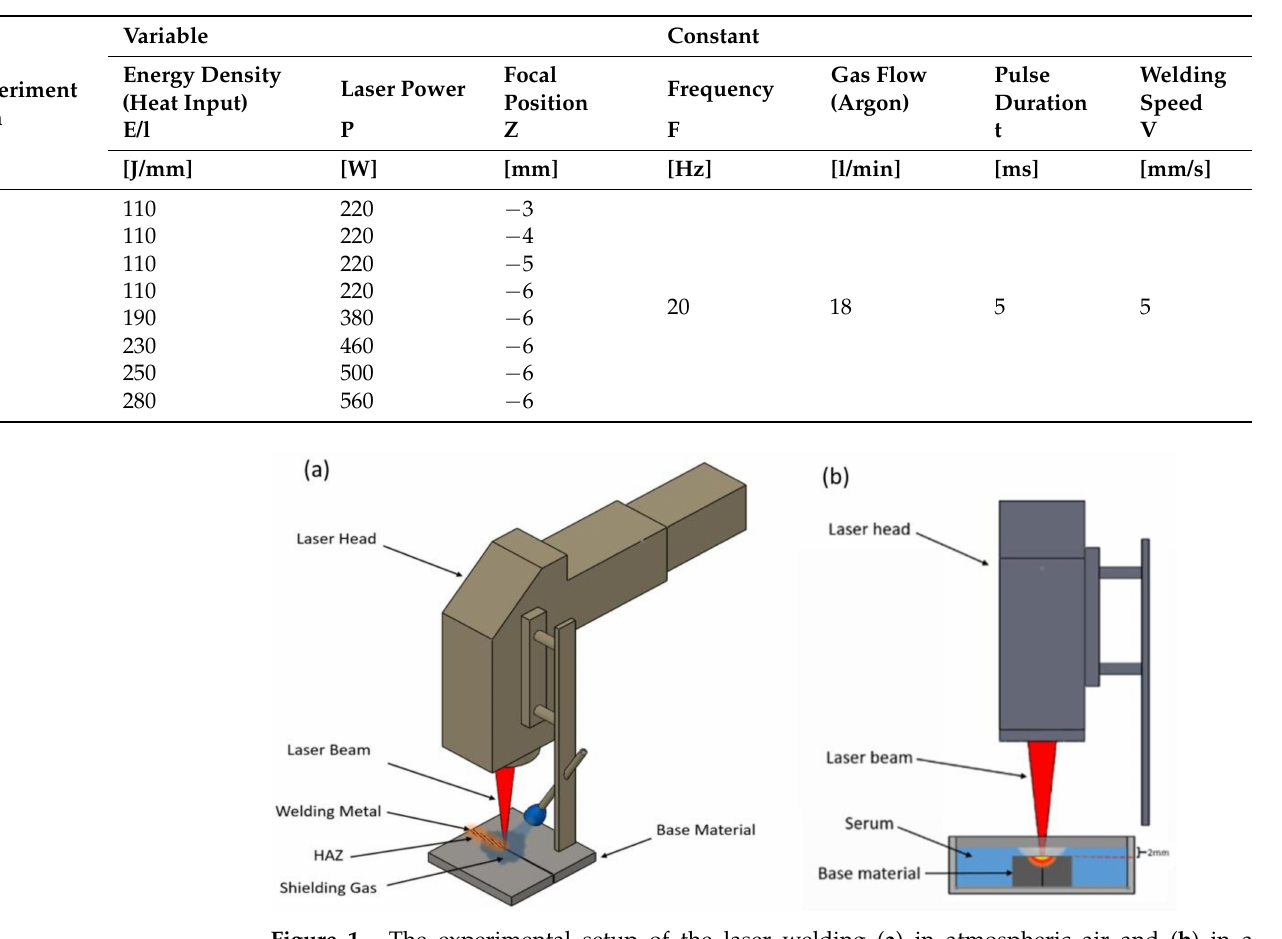
Figure 1. The experimental setup of the laser welding ( a ) in atmospheric air and ( b ) in a serum